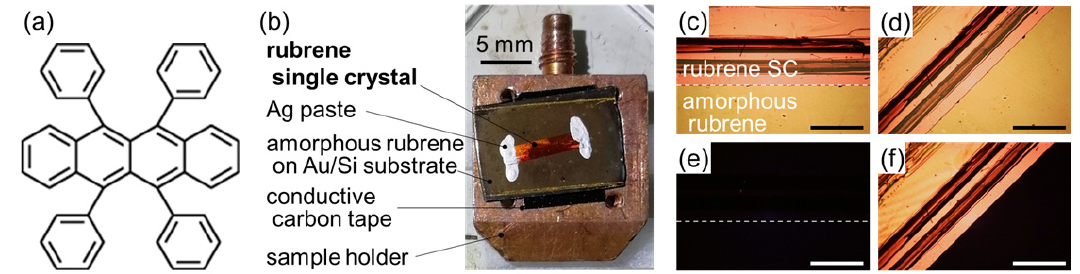
Figure 1. ( a ) Molecular structure of rubrene. ( b ) Photograph of a homoepitaxial rubrene sample for Figure 1. (a) Molecular structure of rubrene. (b) Photograph of a homoepitaxial rubrene sample for photoelectron yield spectroscopy (PYS) measurements. ( c , d ) Optical micrographs of the sample shown photoelectron yield spectroscopy (PYS) measurements. (c, d) Optical micrographs of the sample in ( b ). ( e , f ) Crossed-nicols polarized micrographs at the same sample geometries as ( c , d ), respectively. shown in (b). (e, f) Crossed-nicols polarized micrographs at the same sample geometries as (c) and The scale bars in ( c – f ) correspond to 0.5 mm. The edge of the rubrene single crystal is highlighted with (d), respectively. The scale bars in (c-f) correspond to 0.5 mm. The edge of the rubrene single crystal dashed lines in ( c , e is highlighted with dashed lines in (c) and (e) .